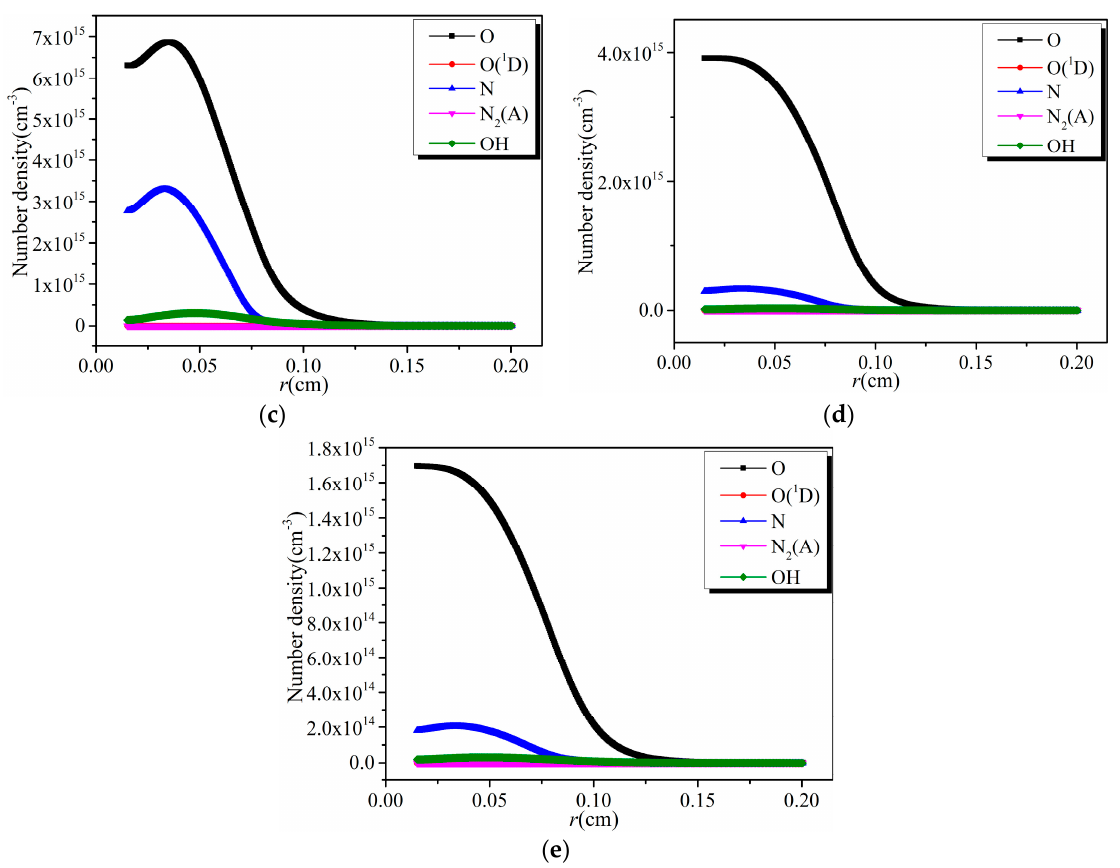
Figure 9. Distribution of the number densities of active particles at various time steps: ( a ) 2.9836 × 10 − 5 s; ( b ) 9.1116 × 10 − 5 s; ( c ) 2.7826 × 10 − 4 s; ( d ) 8.4975 × 10 − 4 s; and ( e ) 2.595 × 10 − 3 s.